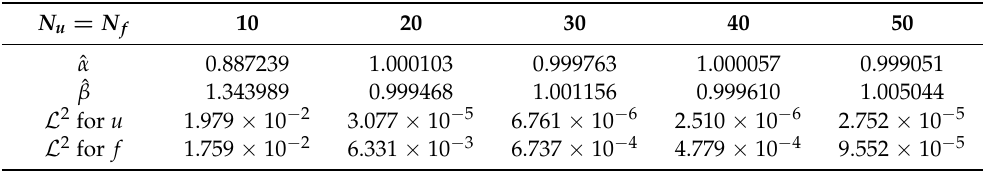
Table 4. Numerical results for Example 3. Impact of the amount of training data: estimated values of ( α , β ) and the relative error L 2 for u ( t , x ) and f ( t , x ) , where ( α , β ) is fixed to be (1,1) and noise-free data is used. N u = N f